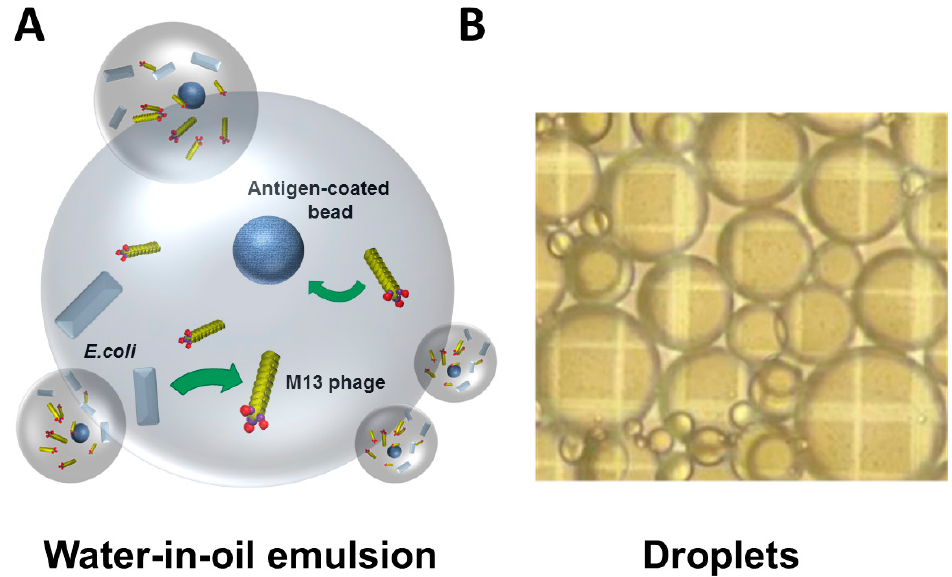
Figure 7. Phage micro-emulsion technology. ( A ) Schematic of phage micro-emulsion technology . A heterodisperse emulsion is produced containing 5–10 phagemid-transduced E. coli and 3–6 antigen- coated beads (or target expressing cells) per microdroplet. Phage secreted from M13-transduced E.